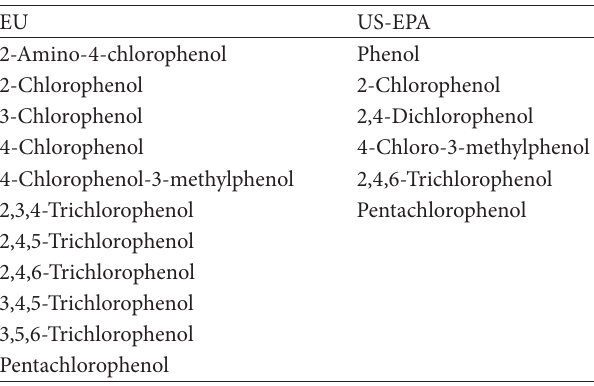
Table 1: Priority contaminants set by EU and US-EPA.